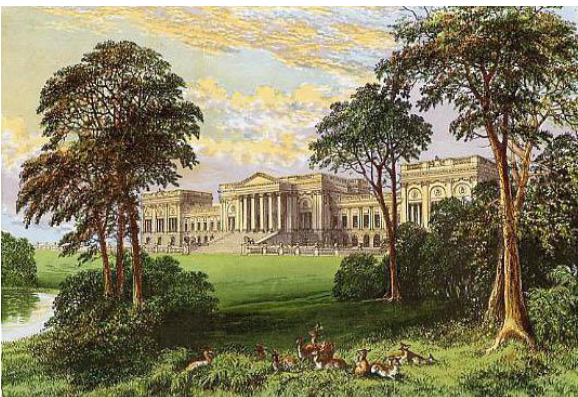
Figure 8. Stowe House in Buckingham shire, England from Morris's ‘Country Seats’ (1880). (Photo from Merchbow